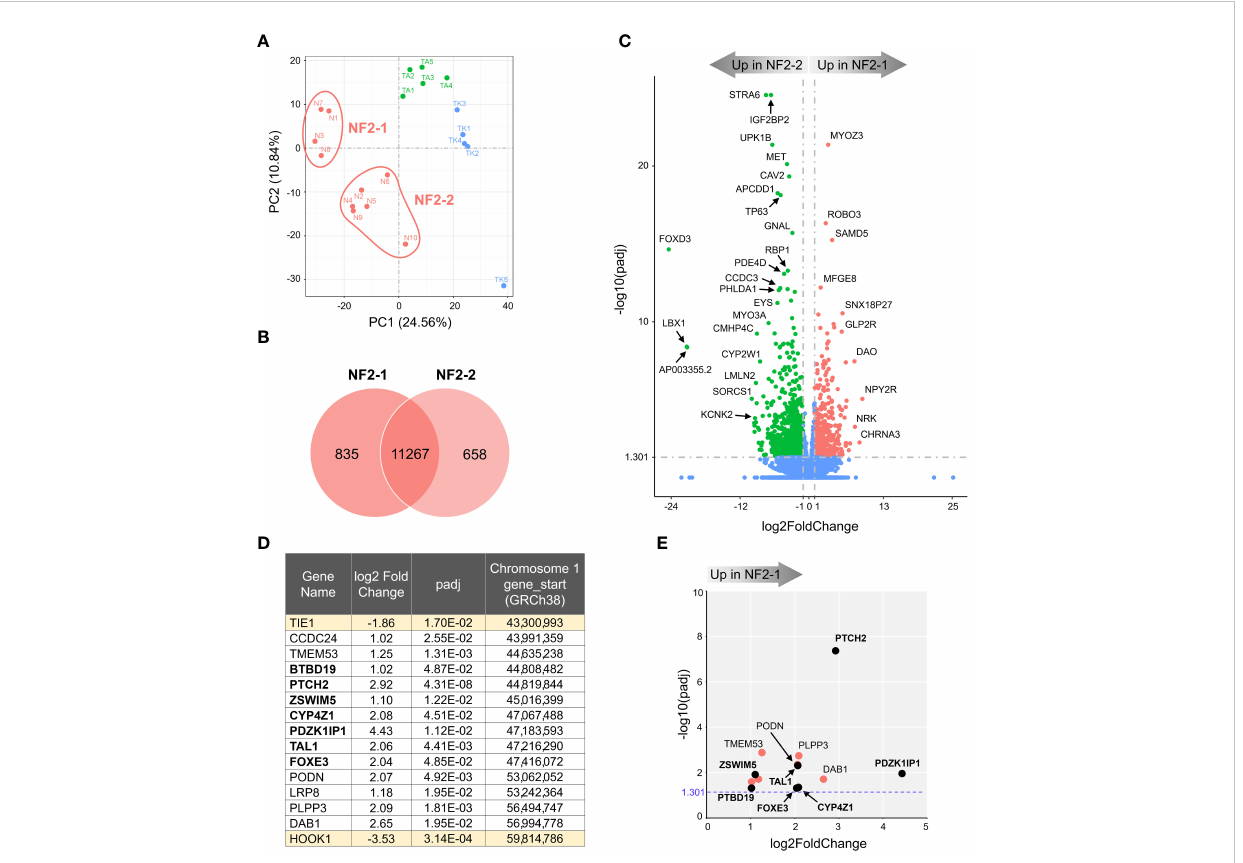
FIGURE 2 Transcriptome analysis of NF2 meningioma groups. (A) Two sub-clusters of NF2 meningioma samples on PCA plot of RNA-seq analysis: four samples in NF2-1 and six samples in NF2-2 groups. (B) Venn diagram showing the overlap of DEGs in NF2 meningioma groups. The numbers of shared and tumor group-speci fi c genes are shown inside the corresponding areas. (C) Volcano plot visualizing signi fi cant DEGs in NF2-1 versus NF2-2 tumors: relative expression (x-axis) vs. statistical signi fi cance (y-axis) of difference in mRNA expression. Genes which are not differentially expressed are shown in blue. The directions of increasingly upregulated genes speci fi c for each group are shown by thick grey arrows above the chart with the corresponding tumor group name in it. DEGs with the highest discrepancy between two groups are indicated. (D) List of 15 DEGs positioned in missing 16.5 Mb long region from chr1p. Table shows the relative expression (log2FoldChange) of a given gene in NF2-1 versus NF2-2 tumors, statistical signi fi cance (padj), and gene start location on chr1p (from Reference GRCh38.p14 Primary Assembly). DEGs located in the smallest region of overlapping chr1p deletions are shown in bold font. (E) Scatter plot of DEGs as listed in table in (D) : relative expression (x-axis) vs. statistical signi fi cance (y-axis) of difference in mRNA expression. DEGs located within the smallest 2.8 Mb region of overlapping chr1p deletions are shown as black dots and marked in bold